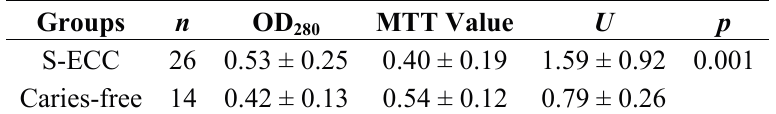
Figure 2. The comparison of Saps activity of C. albicans strains isolated from S-ECC and caries-free children as determined by the MTT method. White bars and black bars represent the means (with standard deviations) of U values (OD Saps activity of C. albicans from S-ECC and CF children. *** denotes statistical significance ( p < 0.001).